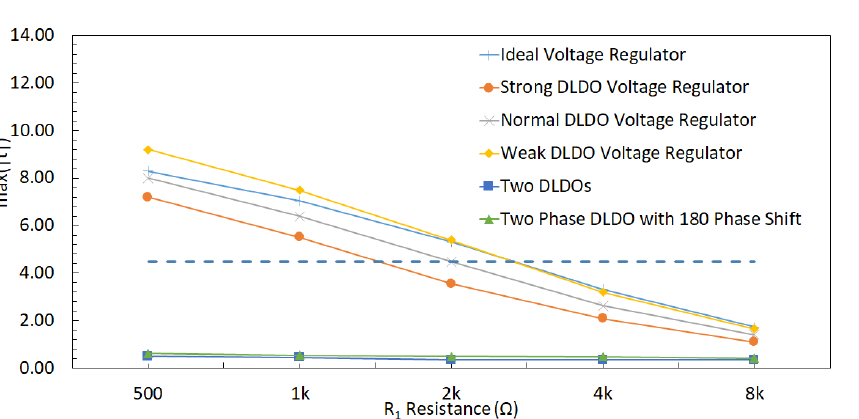
Figure 14. Result of the t -test to evaluate the leakage amount between masking shares with different on-chip voltage regulators when the R 1 is changed from 500 Ω to 8 k Ω with 100,000 traces.